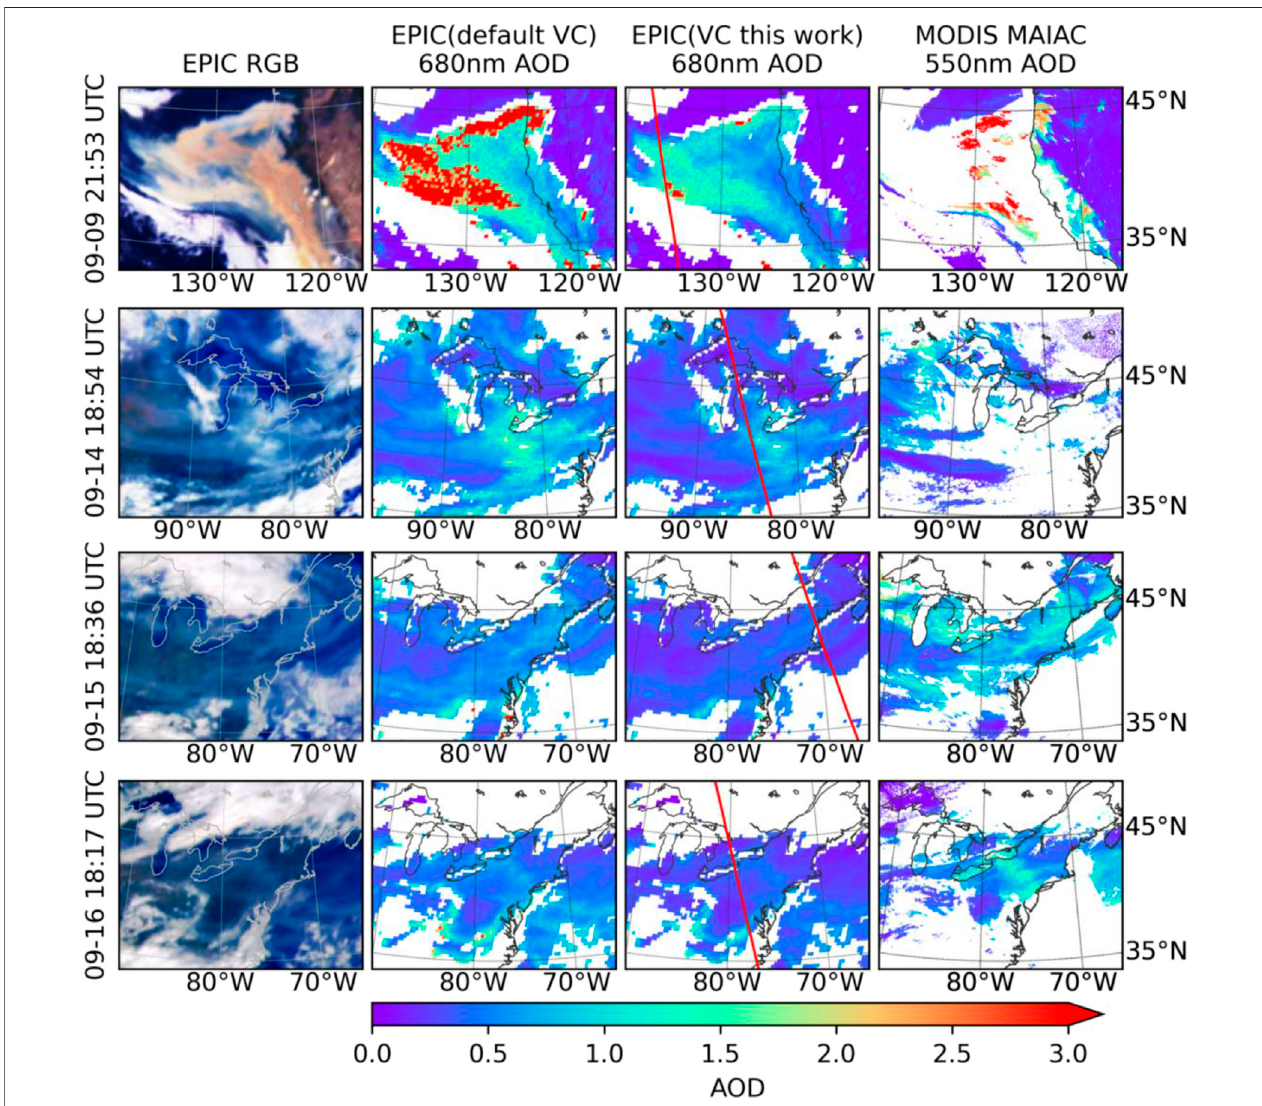
FIGURE 2| Comparison ofEPIC AOD and MODIS MAIAC AOD for September 9 and 14 – 16. The fi rst column is EPIC true color image composed of443, 551 and 680 nm measurements. The second and third columns are EPIC 680 nm AOD retrievals without and with vicarious calibration. The red lines in the third columns are the CALIOP sub-orbital tracks on each day. The last column is MODIS MAIAC AOD at 550 nm.